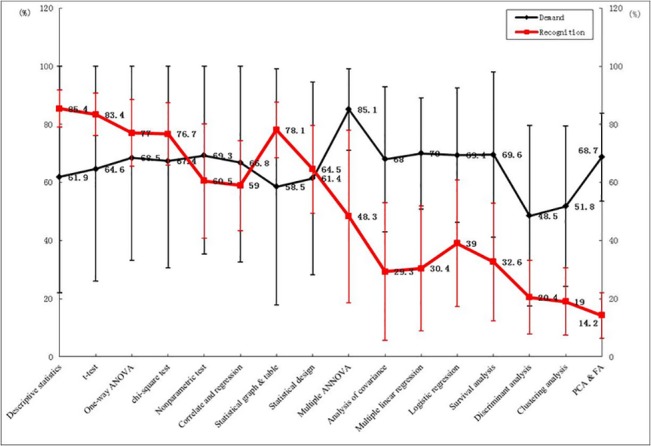
Relative Rate of Change in the Cognition of and Demand for Basic and Advanced Statistical Methods.(Basic statistical methods: descriptive statistics, t-test, one-way ANOVA, chi-squared test, nonparametric test, correlation and regression, statistical graphs and tables as well as statistical design. Advanced statistical methods: multiple ANOVA, analysis of covariance, multiple linear regression, logistic regression, survival analysis, discriminant analysis, clustering analysis, and PCA & FA.).